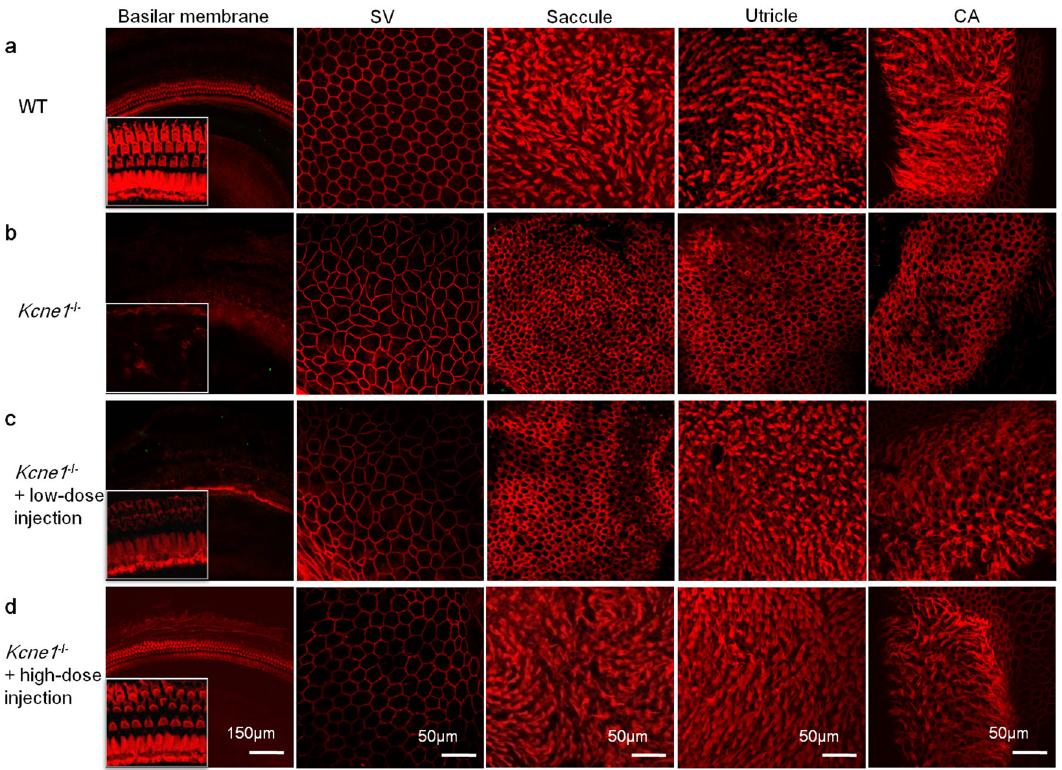
Fig. 4 Isothiocyanate-conjugated phalloidin labels both cell membrane and ciliary bundles for comparisons of the morphologies of the WT, untreated, and low- and high-dose-treated Kcne1 − / − mice at P30 ( n = 4 in each group). a The morphologies of marginal cells (MCs), ciliary bundles of cochlear, and vestibular hair cells (HCs) in WT mice as labeled. b The morphologies of MCs, ciliary bundles of cochlear, and vestibular HCs in untreated Kcne1 − / − mice. c The morphologies of MCs, ciliary bundles of cochlear, and vestibular HCs in low-dosage-treated Kcne1 − / − mice. The ciliary bundles of vestibular HCs in the utricle and crista ampullaris (CA) were signi fi cantly preserved. d The morphologies of MCs, ciliary bundles of cochlear, and vestibular HCs in high-dosage-treated Kcne1 − / − mice. The shape of the MCs and the ciliary bundles of the HCs in the cochlear and vestibular organs seemed to have recovered to normal. Red: